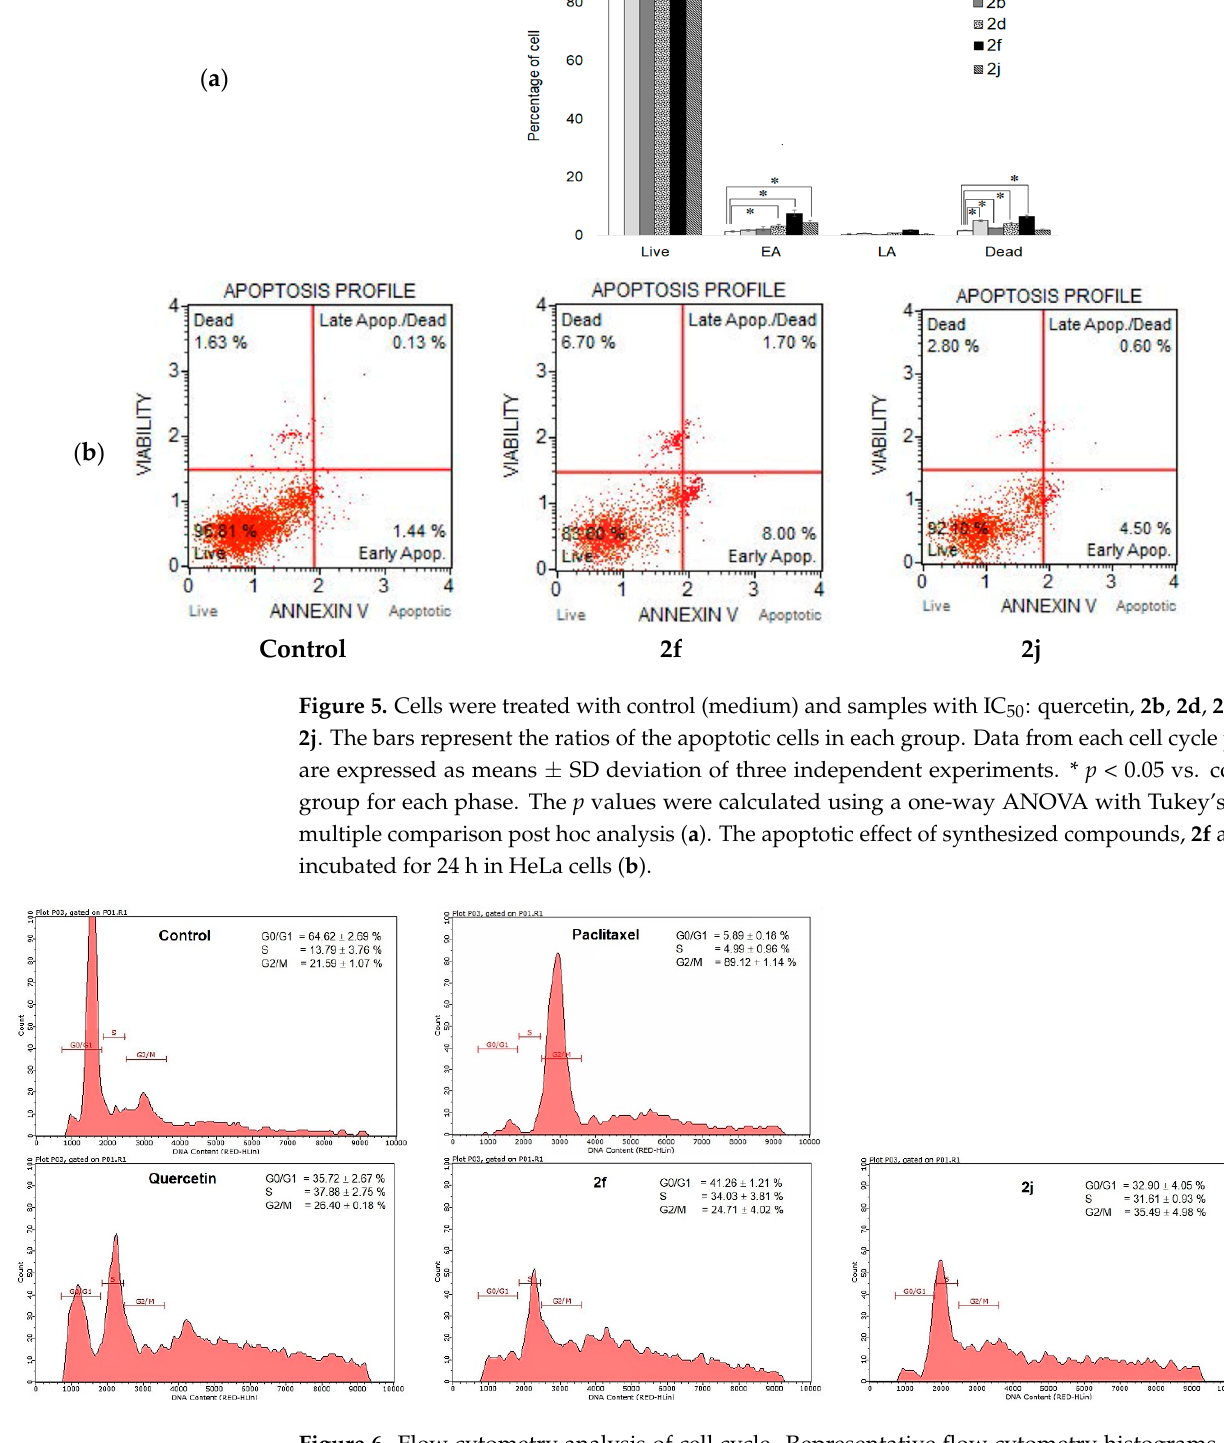
Figure 6. Flow cytometry analysis of cell cycle. Representative fl ow cytometry histograms of the percentage of cells in G0/G1, S, and G2/M phases of the cell cycle in HeLa cells. Cells treated with 2f , 2j , quercetin with concentration at IC 50 , paclitaxel (5 µM), or untreated control for 24 h. Control and treated cells were fi xed, stained, and analyzed by fl ow cytometry as per the Muse ® cell cycle kit protocol.